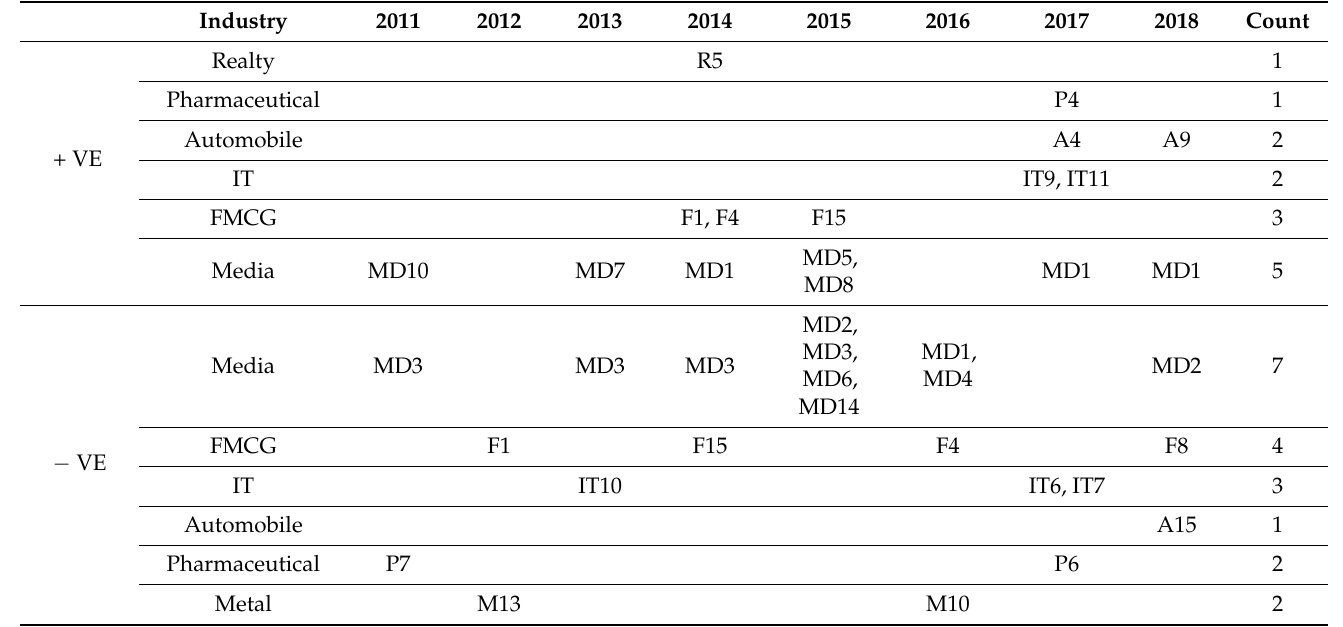
Table 6. Firms showing excessing earnings management, tabulated by